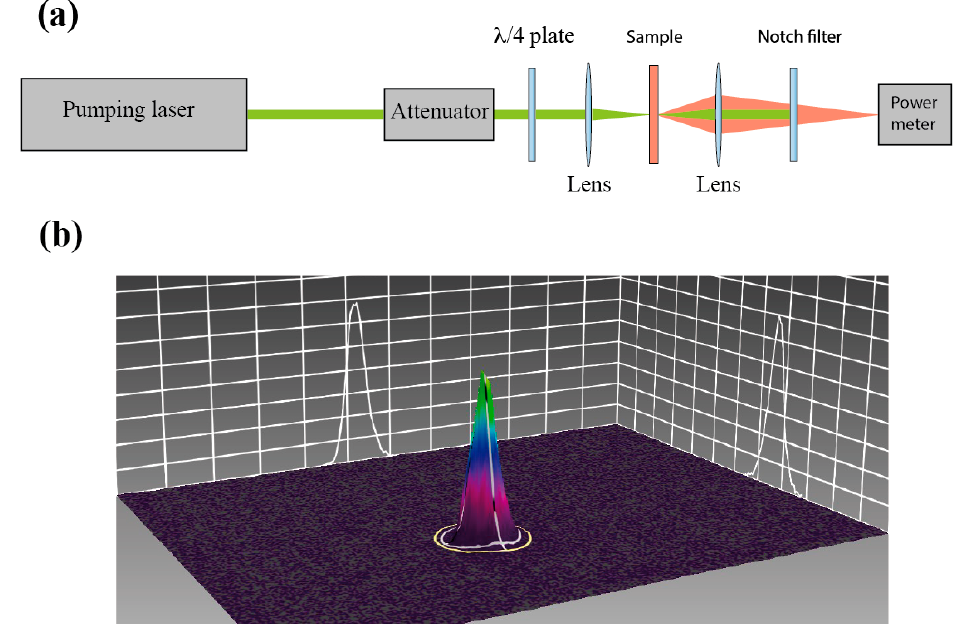
Figure 7. ( a ) Experimental setup used to characterize the laser performance of the different cell architectures; ( b ) Beam profile of the pumping laser on the sample. As can be seen the spot roughly presents a Gaussian intensity distribution.